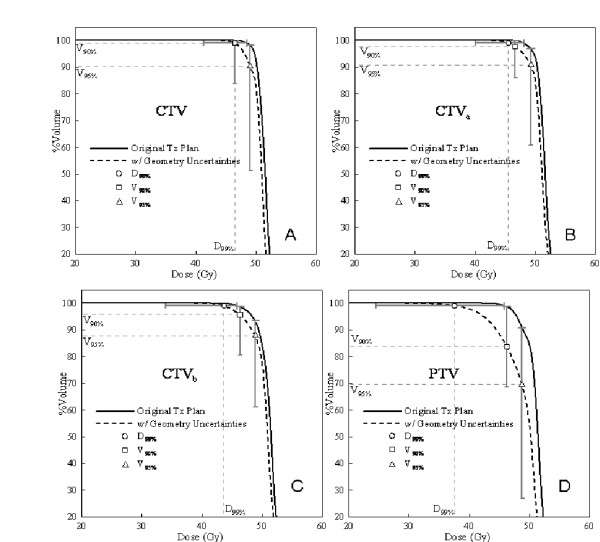
The effects of geometric uncertainty on the DVH of different targets. The DVH curves are the mean curves from different patients in this study. (a), (b), (c) & (d) correspond to CTV, CTVa, CTVb, and PTV, respectively. The ο, □, Δ symbols show the mean reduction of the D99%V, V90%D, and V95%D from the original DVH curves. The bar across the symbols are the range of the data set.